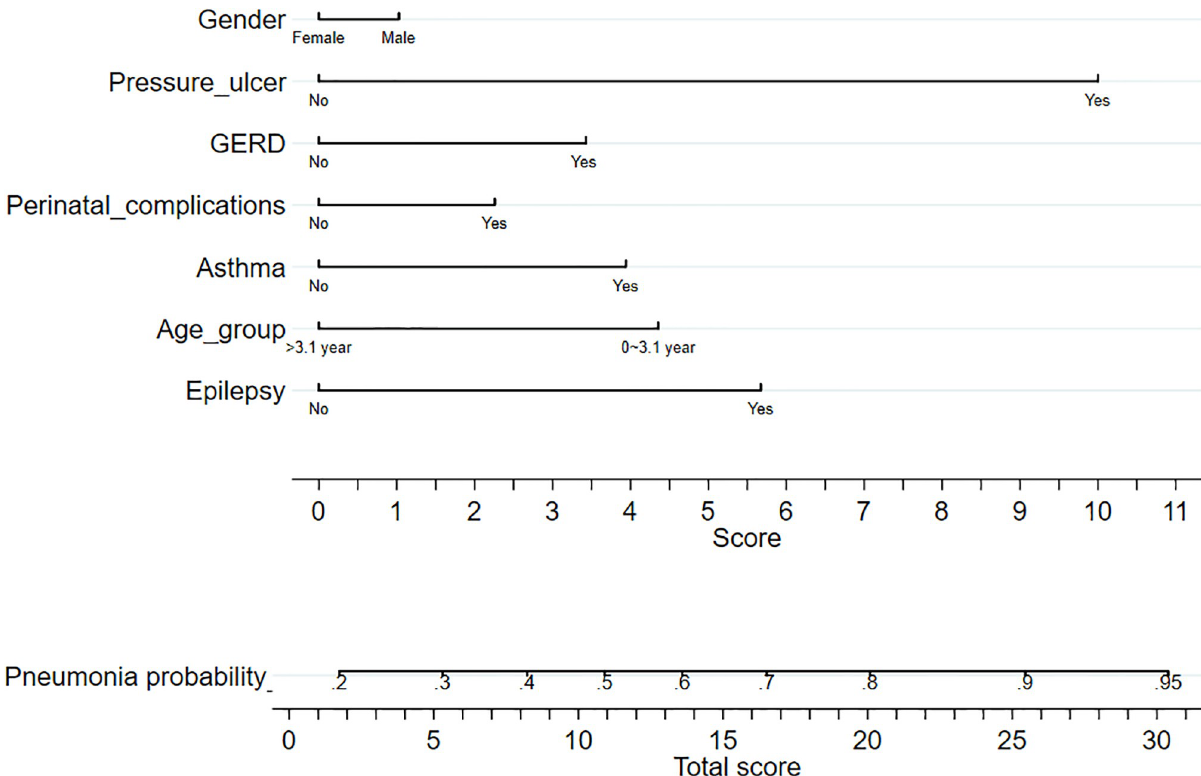
Fig 1. Nomogram plot for predicting severe pneumonia in CP children. For an individual patient, each variable corresponds to a point in the 8 th row (names “score”). The total points were summed up by all points and are indicated in the 10 th row (the bottom row). Drawing a vertical line from total point to the 9 th row will show the corresponding probability of